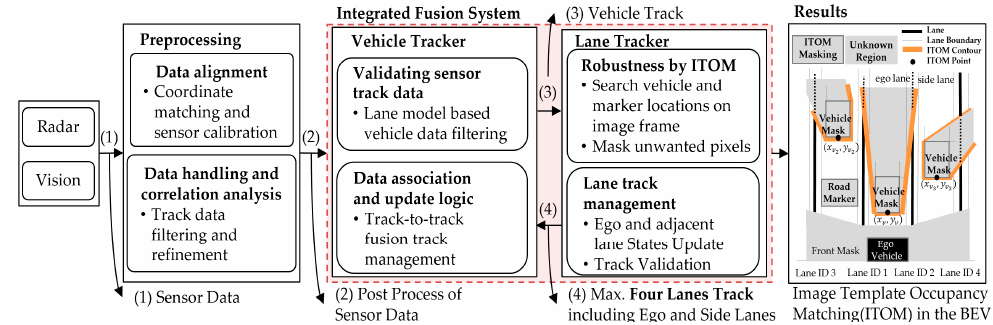
Figure 1. System overview of the multi-sensor data fusion framework.